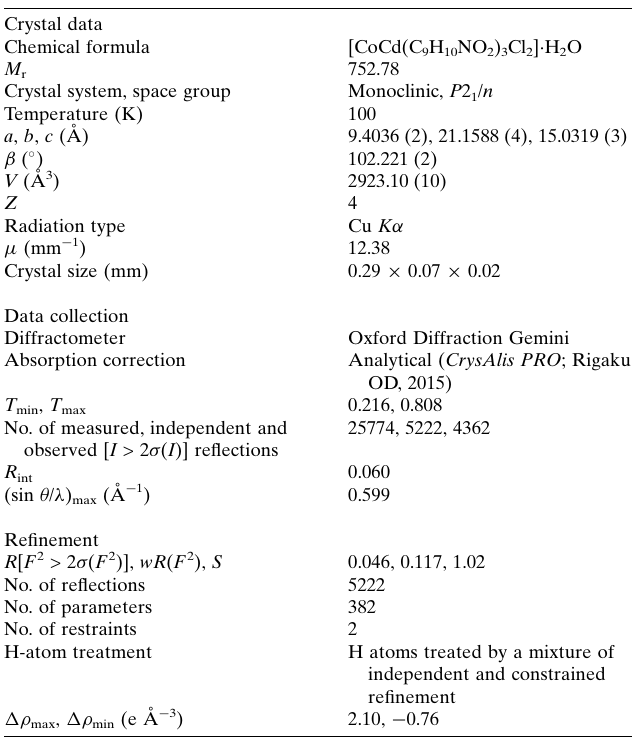
Table 3 Experimental details. Crystal data Chemical